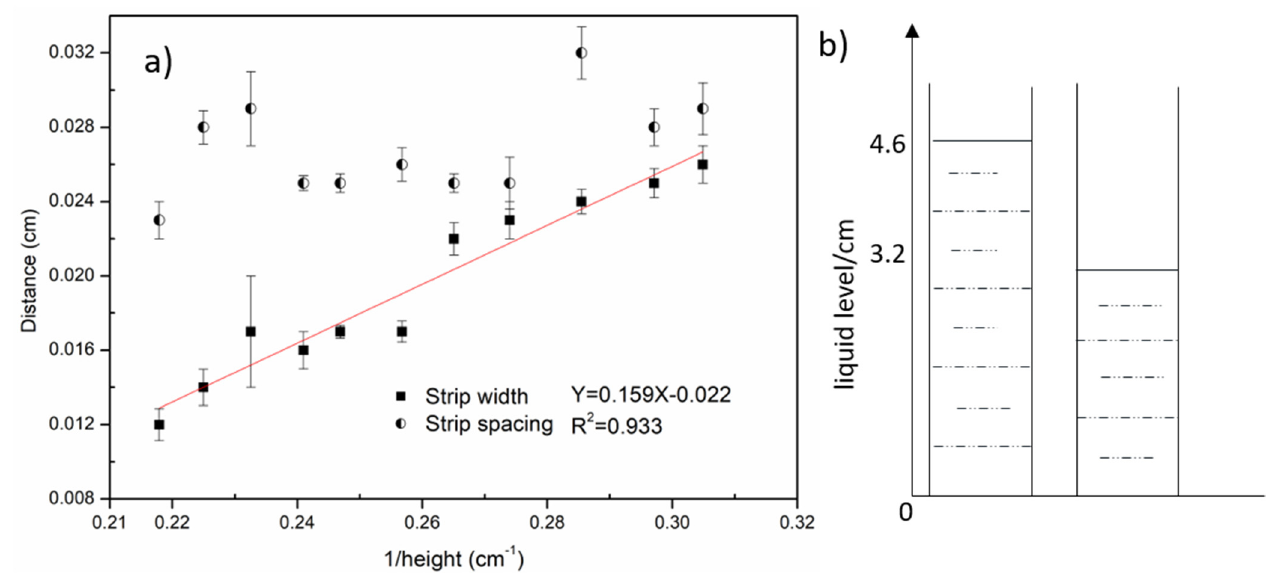
Figure 3. ( a ) Ring width and ring spacing as the 1/height of receding liquid level with standard deviations (the particle concentration increased with 1/height) for the rings that formed due to the evaporation of water from a purified hydrochar dispersion CH3.63–SDS; ( b ) measurement of the height of the receding liquid level in a glass vial.